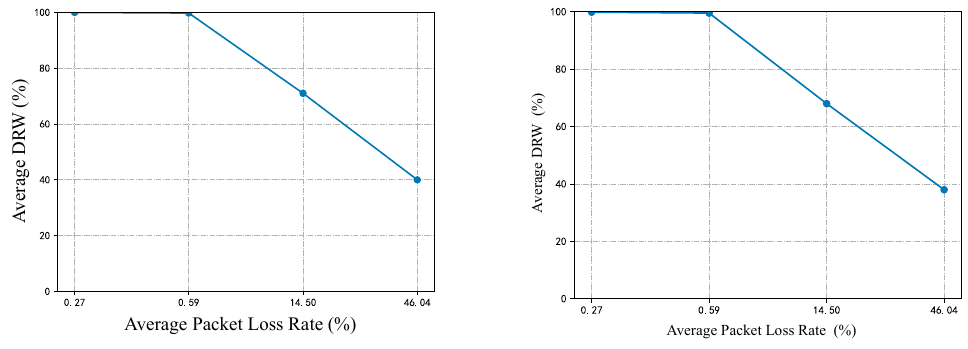
Figure 10. The DRW in the different packet loss rate.